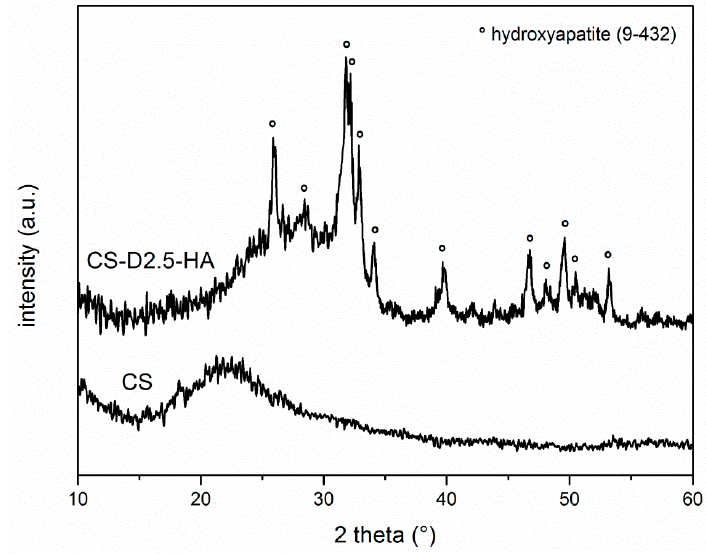
Figure 3. XRD spectra of CS-D-HA hydrogel.